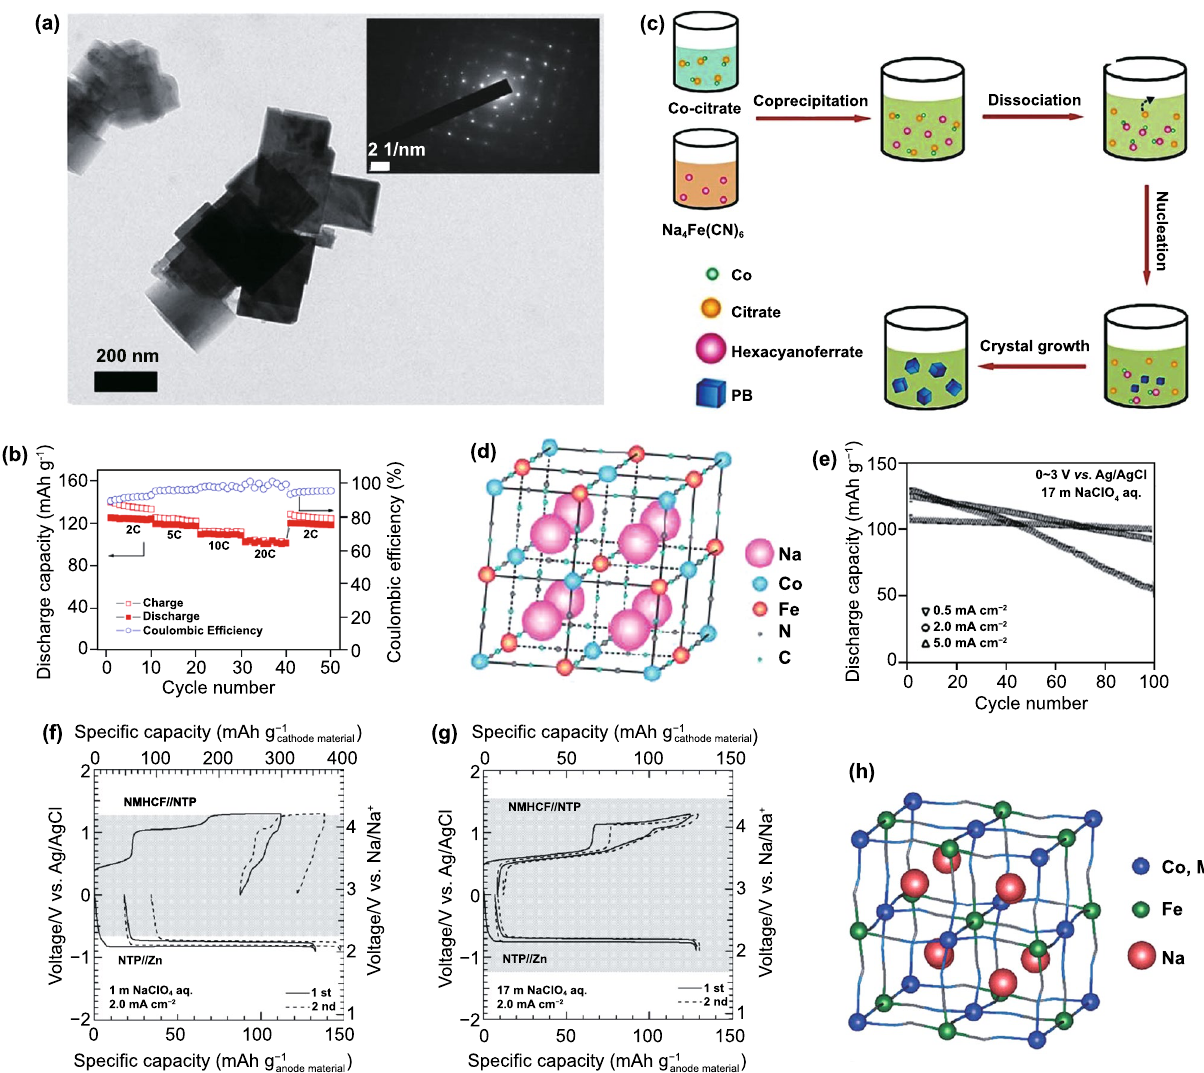
Fig. 7 a TEM images of as-prepared Na 1.33 Fe[Fe(CN) 6 ] 0.82 nanocrystals. b Rate performance of Na 1.33 Fe[Fe(CN) 6 ] 0.82 . Reproduced with per- mission from Ref. [104]. Copyright 2015, Elsevier. c Schematic representation of the formation mechanism of Na 2 CoFe(CN) 6 in a controlled crystallization reaction. d Crystal structure of Na 2 CoFe(CN) 6 . Reproduced with permission from Ref. [105]. Copyright 2015, Wiley–VCH. e Cyclability dependence on the current density of Na 2 MnFe(CN) 6 half cell with 17 M NaClO 4 aqueous electrolyte. The first and second charge/ discharge curves of Na 0.13 Mn[Fe(CN) 6 ] 0.81 /NaTi 2 (PO 4 ) 3 full cell and NaTi 2 (PO 4 ) 3 //Zn half cell f in 1 M NaClO 4 electrolyte and g in 17 M